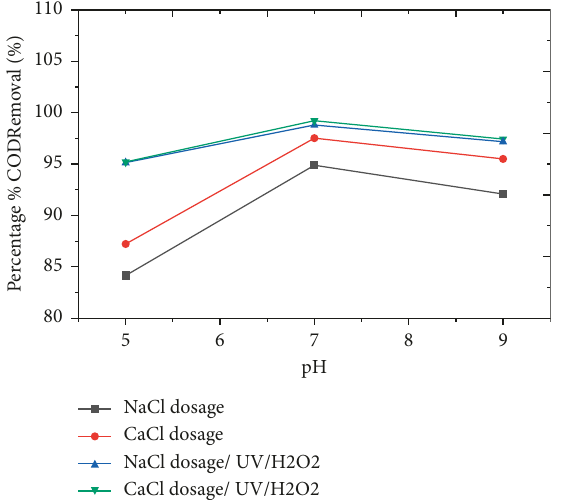
Figure 4: Effect of current on COD removal efficiency from coffee processing